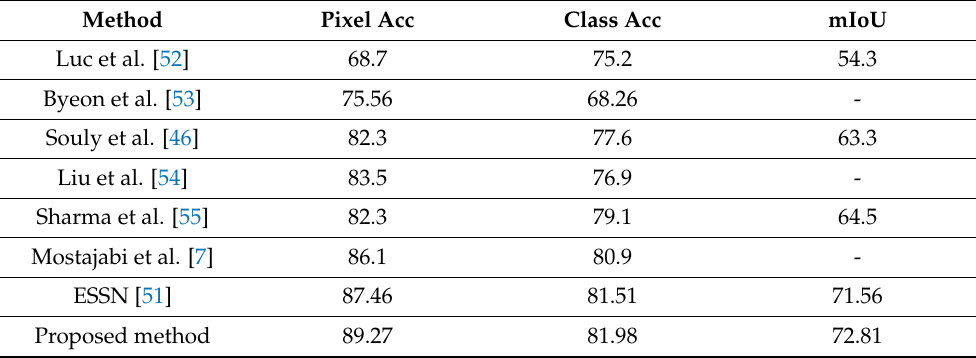
Table 9. Comparisons of the proposed method with state-of-the-art methods (unit: %).